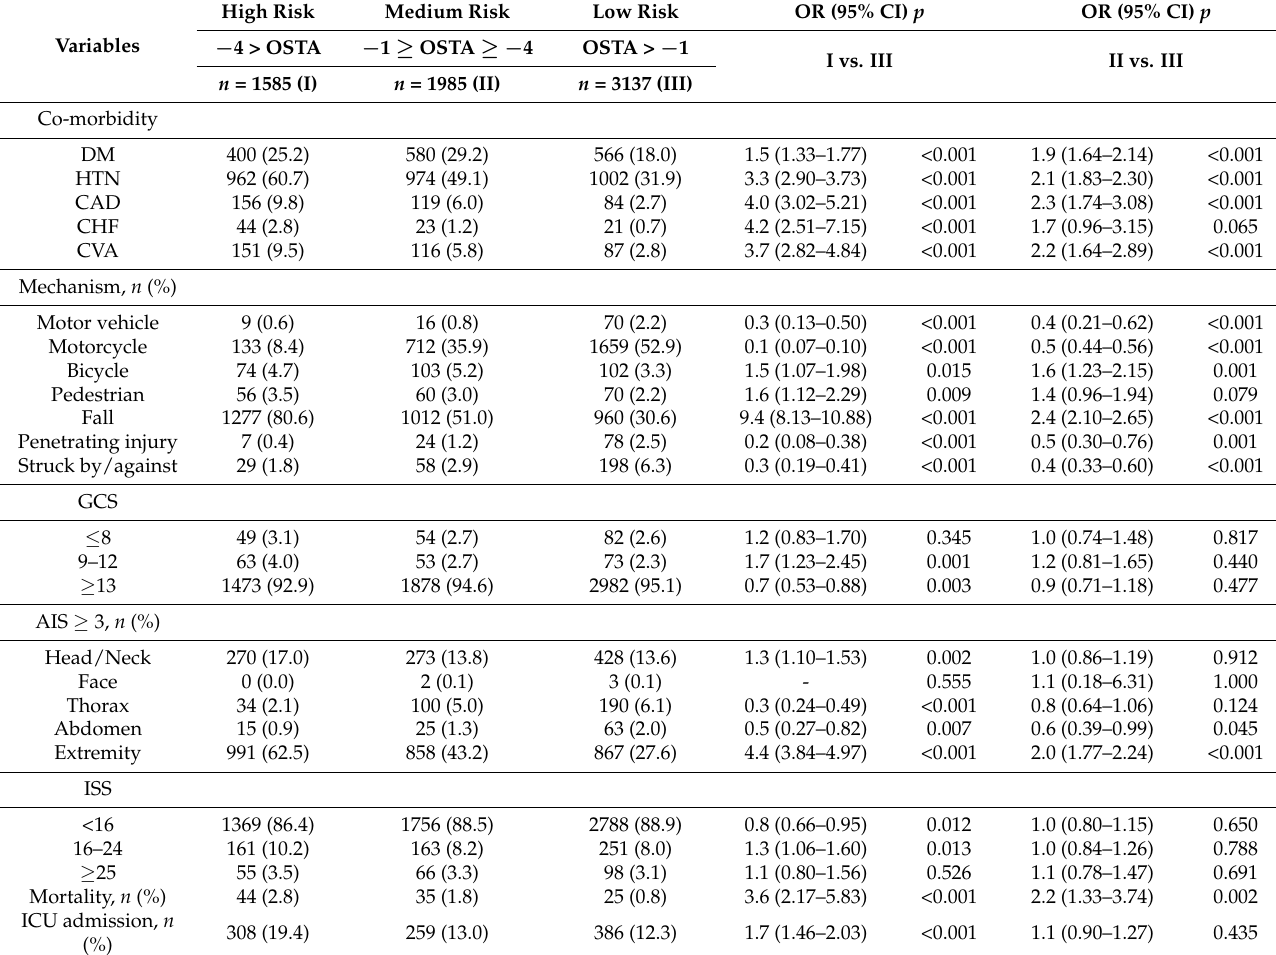
Table 2. Demographics and injury characteristics of categorical variables in high-risk (OSTA < − 4), medium-risk ( − 1 ≥ OSTA ≥ − 4), and low-risk (OSTA > − 1)